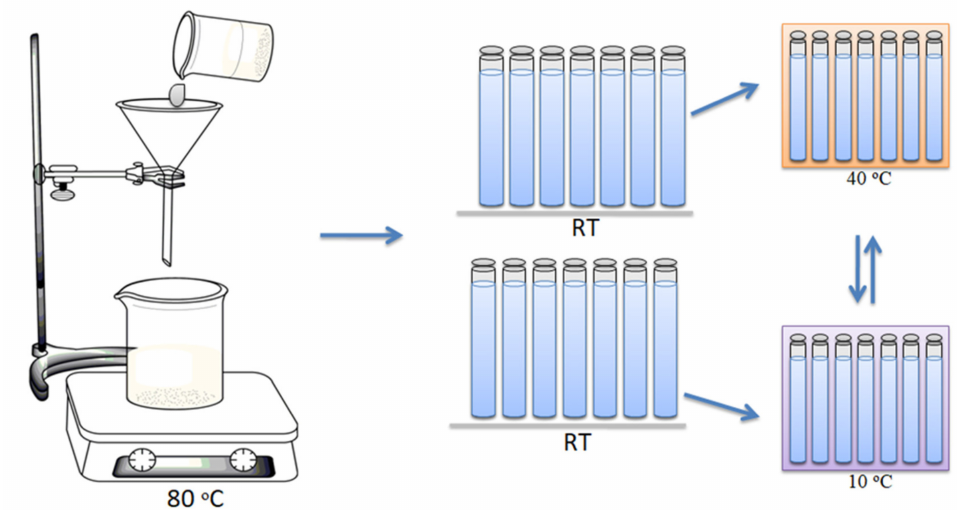
Figure 1. Material preparation and distribution for cycle test process.